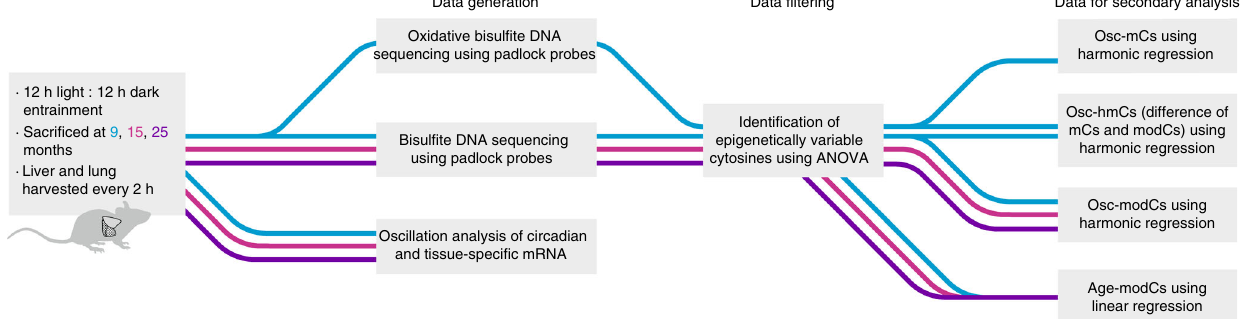
Fig. 1 Experimental work fl ow summary. We investigated 9-, 15-, and 25-month-old (mo) male mice entrained on a 12 h light : 12 h dark cycle with ad libitum access to food. The circadian entrainment of mice was veri fi ed using locomotor activity and mRNA pro fi les of key circadian genes. The confounding effects of cellular heterogeneity were examined using cell-speci fi c non-circadian mRNAs. All sequencing experiments were performed in technical triplicates. ANOVA was used to select for cytosines whose variation of modi fi cation densities were larger in the biological samples compared with technical replicates, which we refer to as epigenetically variable cytosines (EVCs). 5-Hydroxymethylcytosine densities were estimated by subtracting mC from modC densities on CpG sites that are intersected across EVCs. Aging and oscillating cytosines were identi fi ed using linear and harmonic regression models, respectively. Age-modC, age-correlated cytosine modi fi cations; Osc-hmC, oscillating 5-hydroxymethylcytosines; Osc-mC, oscillating 5-methylcytosines; Osc-modC, oscillating modi fi ed